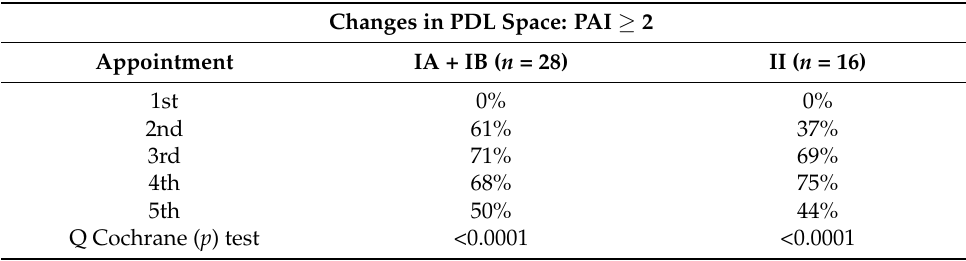
Table 6. Variation of PAI index during the whole course of orthodontic treatment with FOAs. PAI score 2 and 3 fractions (%).